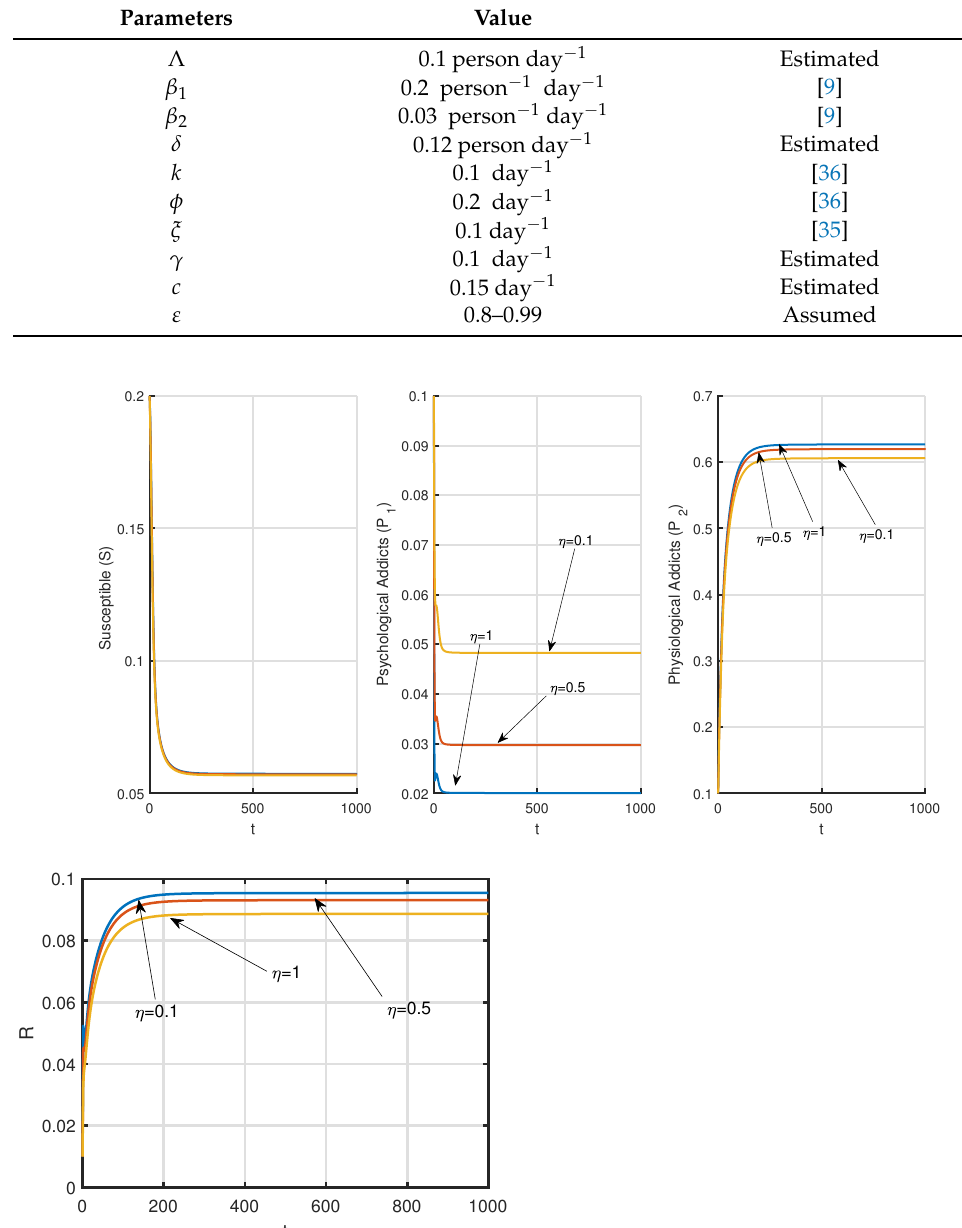
Table 7. Parametric values used in system (26).